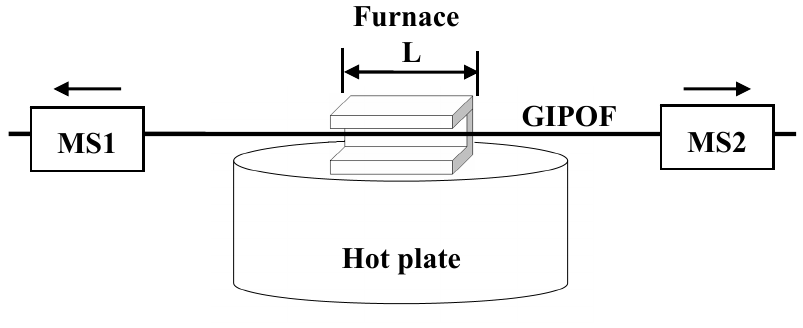
Figure 3. Experimental setup: The GIPOF is heated in the furnace and pulled by two motorized stages (MS1, MS2).